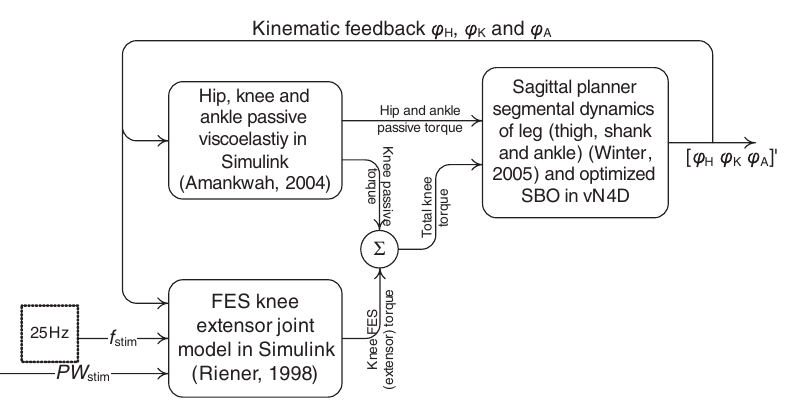
Fig. 2. The simulation model schematic. ϕ H , ϕ K and ϕ A are hip, knee and ankle angles respectively.